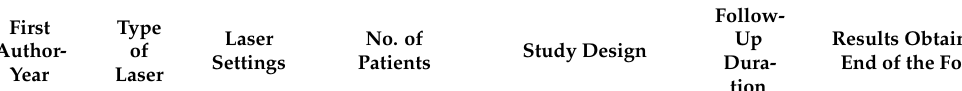
Table 3. Use of diode laser in peri-implantitis